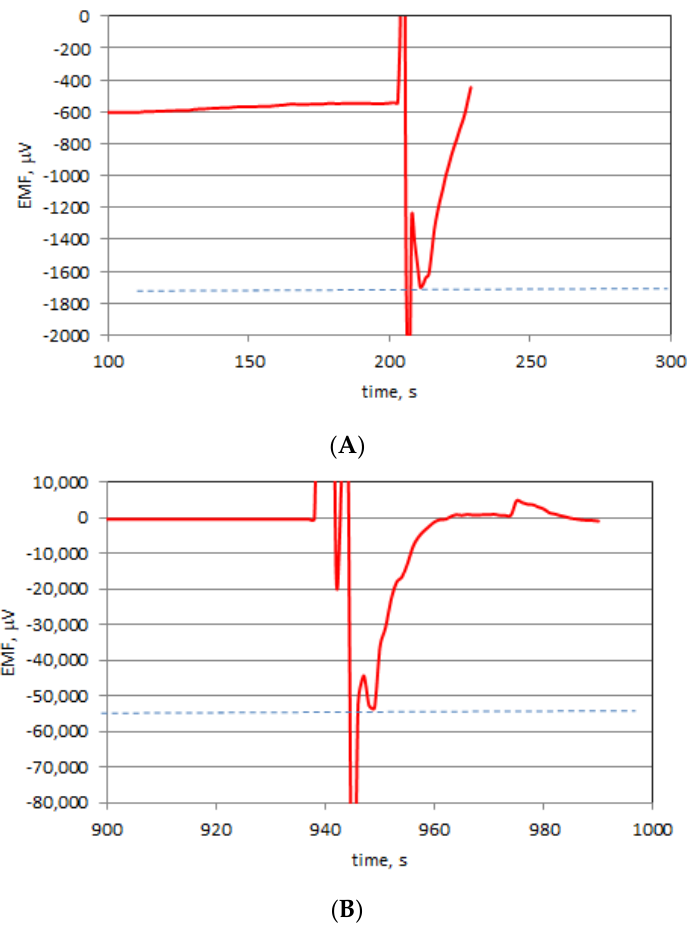
Figure 5. Time profile of EMF during tests of gunpowder ignition with ( A ) BWC bulk (T 1 = 132.2 ± 14 °C, T 2 = 34.0 ± 1.1 °C) and ( B ) BWC monolith covered by gunpowder (T 1 = 144.7 ± 1.6 °C, T 2 = 40.7 ± 2.9 °C).